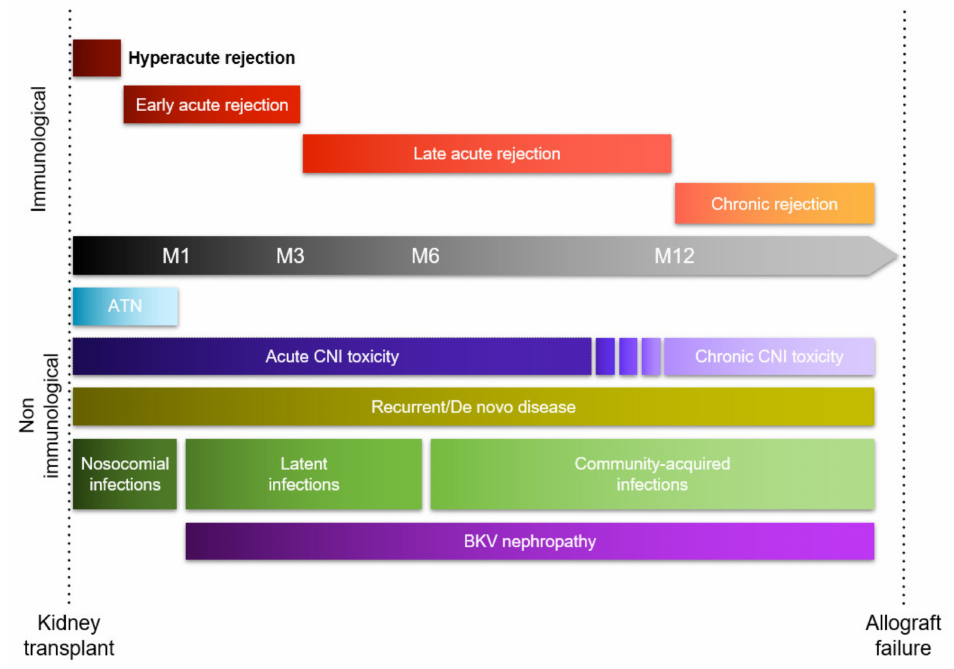
Figure 1. Timeline of early and late causes of graft